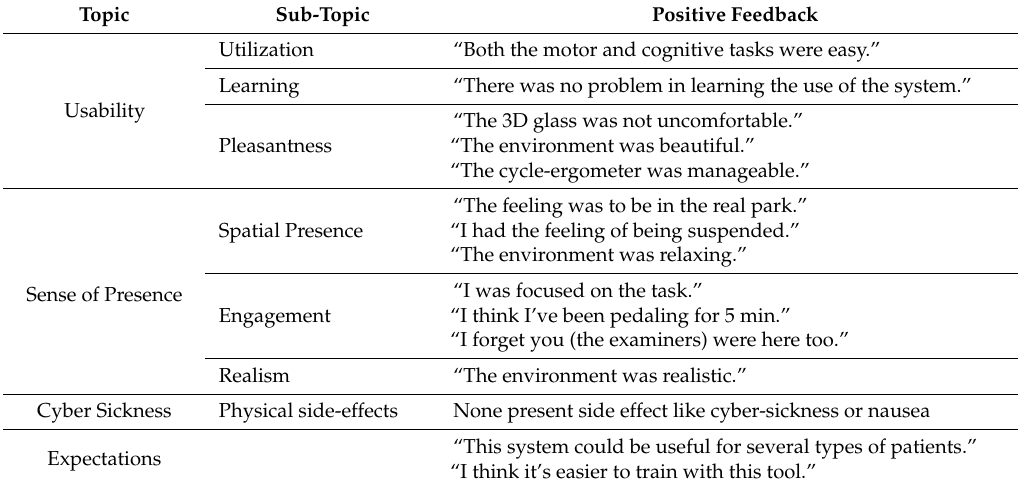
Table 5. Positive feedbacks from formative